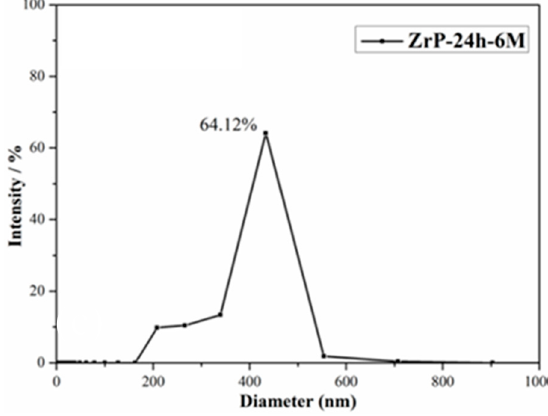
Figure 5. Particle size distribution of ZrP nanoplates.